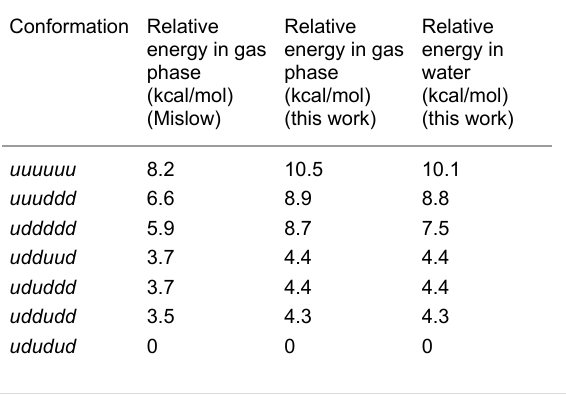
Table 4: Calculated energies for hexaethylbenzene